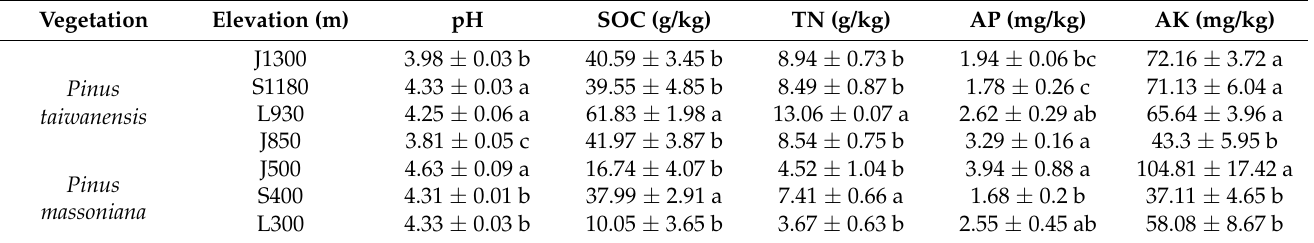
Table 1. The soil characteristics in Pinus taiwanensi and Pinus massoniana forest soils with the